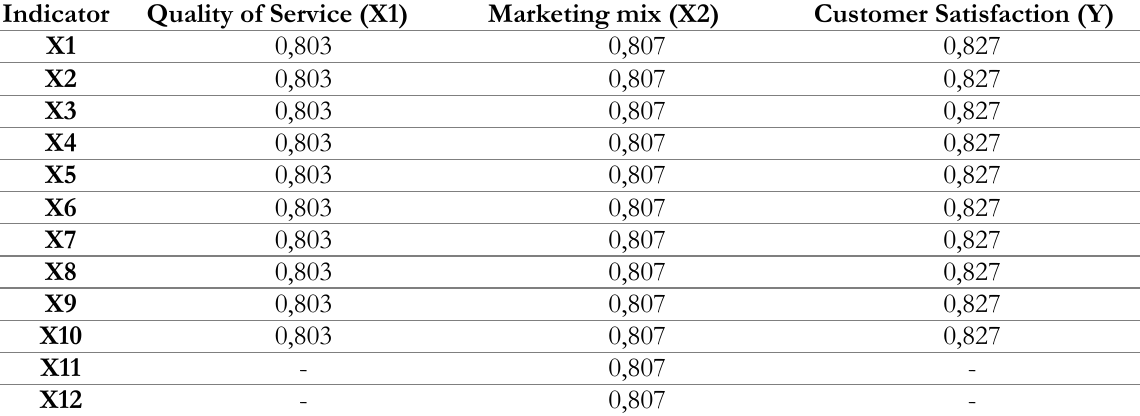
The Outer Model Evaluation Loading Factor Values